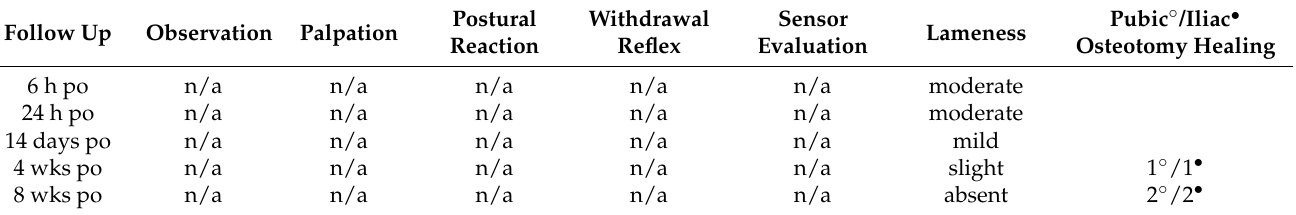
Table 1. Dog Golden Retriever, F, 7 m: overview table of postoperative neurological (observation, palpation, postural reaction, spinal reflex and sensory evaluation), orthopedic (lameness) and radiographic assessment (pubic/iliac osteotomy healing). One example is given because of the similar findings.